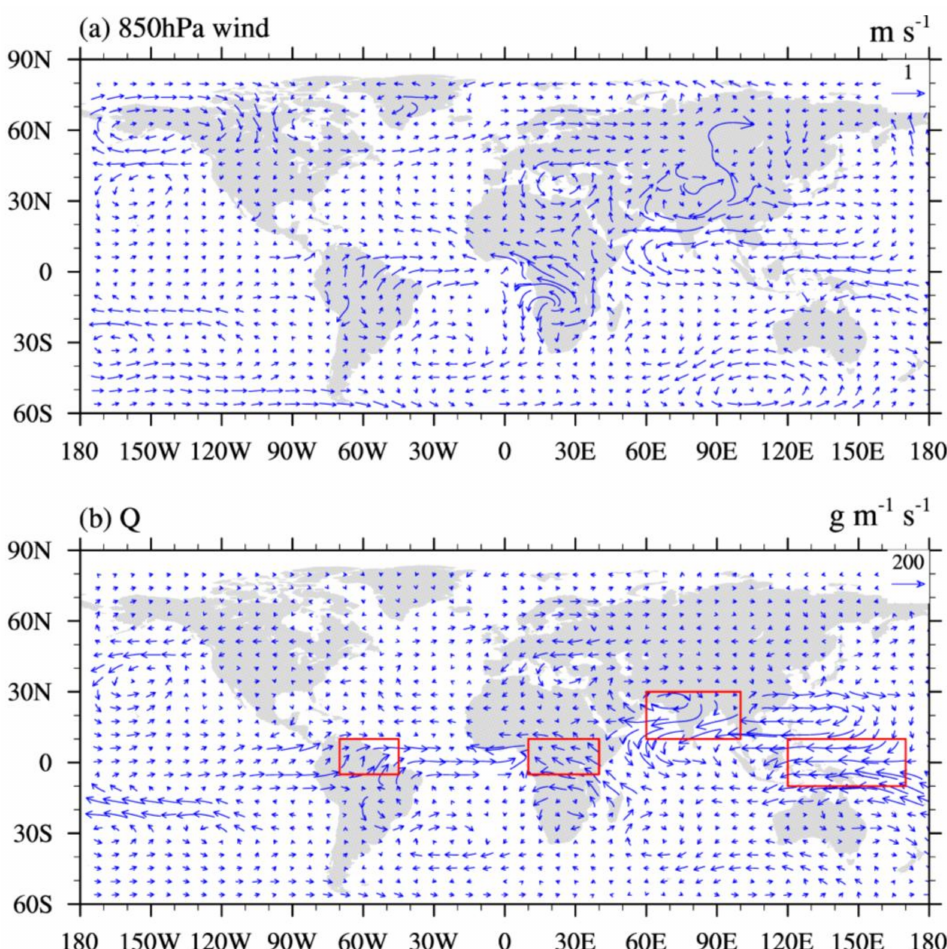
Figure 8. Twenty-four-year (1982–2005) mean difference of: ( a ) 850 hPa wind field (m s − 1 ); ( b ) water-vapor flux (g m − 1 s − 1